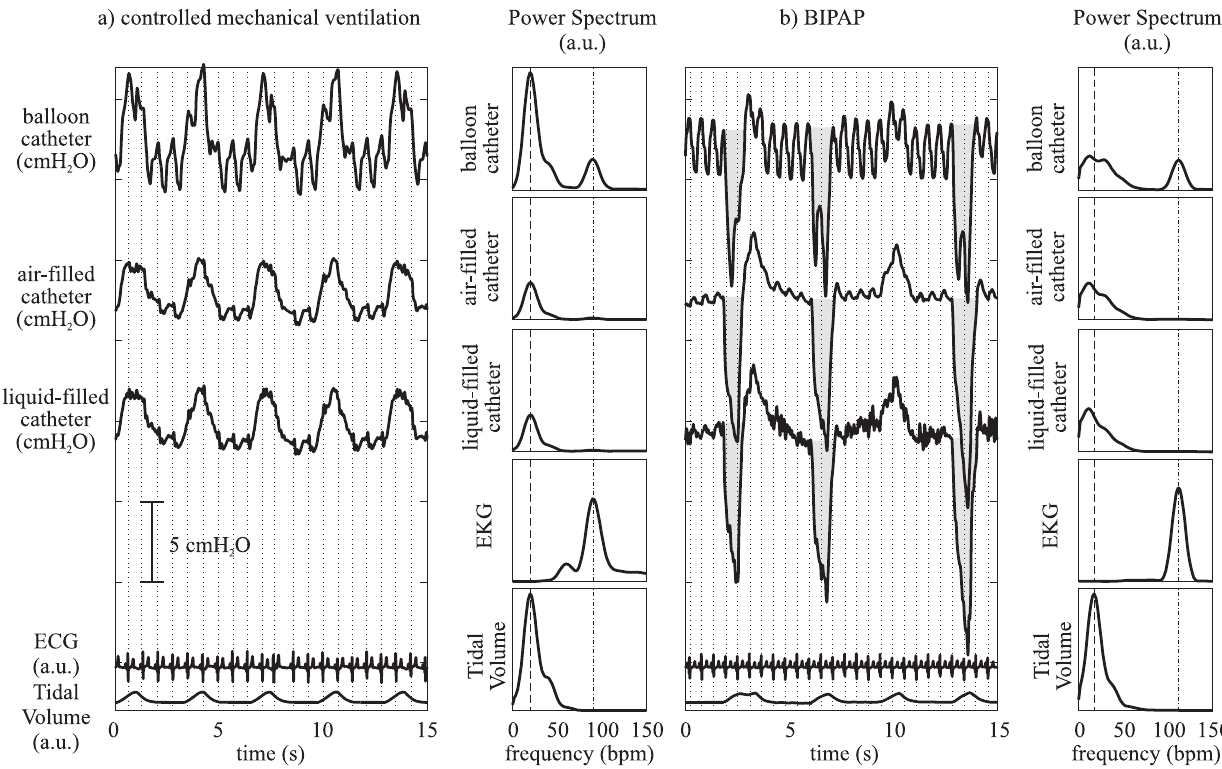
Figure 2. Representative esophageal pressure measurement tracings during a) controlled mechanical ventilation and b) biphasic positive airway pressure (BIPAP) ventilation with spontaneous breathing (note: offsets between the tracings are just for pictorial representation). The balloon catheter tracings show large oscillations that are coherent with the heart-beats occurrences in the EKG (the dotted vertical lines represent the occurrence of the R-peaks of the EKG, i.e. ventricular contraction). To the right side of the tracings the power spectra of each esophageal pressure signal is shown, disclosing that the largest amount of the power is concentrated at frequencies compatible with the respiratory spectrum (dashed line represents the average respiratory rate). Interestingly, only the balloon catheter presents a peak of considerable power at frequencies compatible with the EKG spectrum (the dash-dot lines represent the average heart rate). The pressure-time product (PTP) is graphically represented by the gray areas in panel b): in the balloon tracings it is evident that cardiogenic noise affects the shape of the area, modifying the estimated value of PTP.